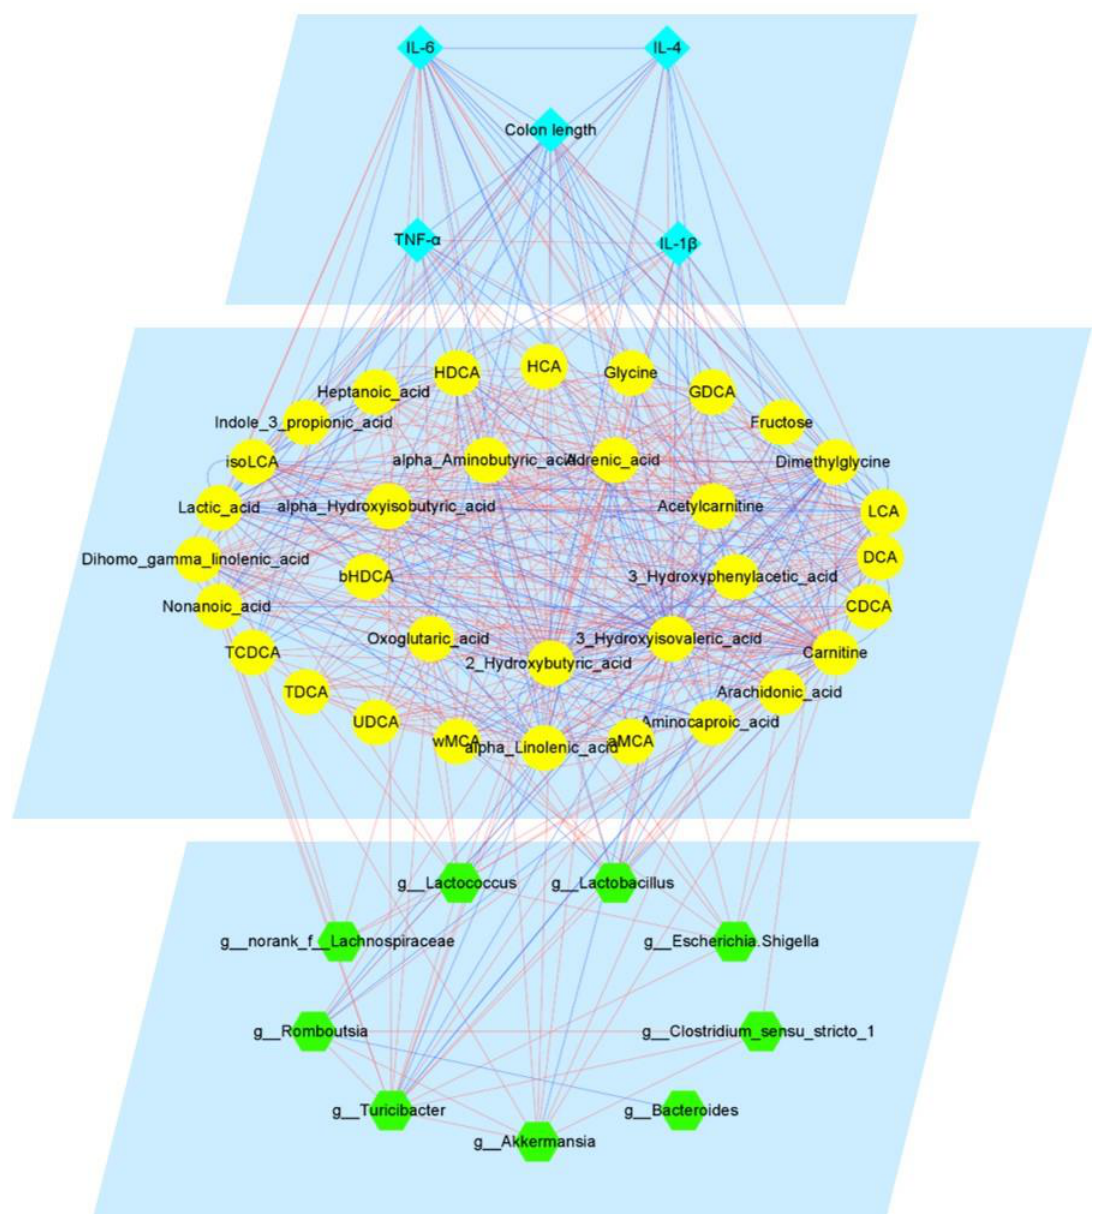
Figure 7. The integrated therapeutic mechanism of Pae in treating UC. The edges are the correlations with Spearman’s correlation coefficient < − 0.6 (or >0.6) and p < 0.05. The inner layer edges are represented by blue lines and the between layer edges are represented by red lines.